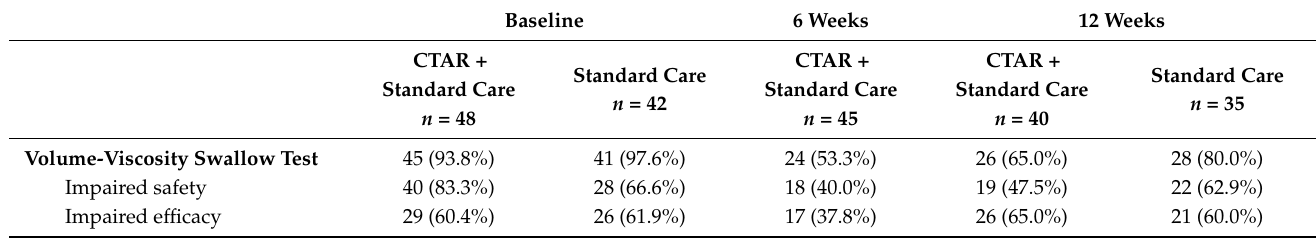
Table 3. Descriptive information on outcome data.